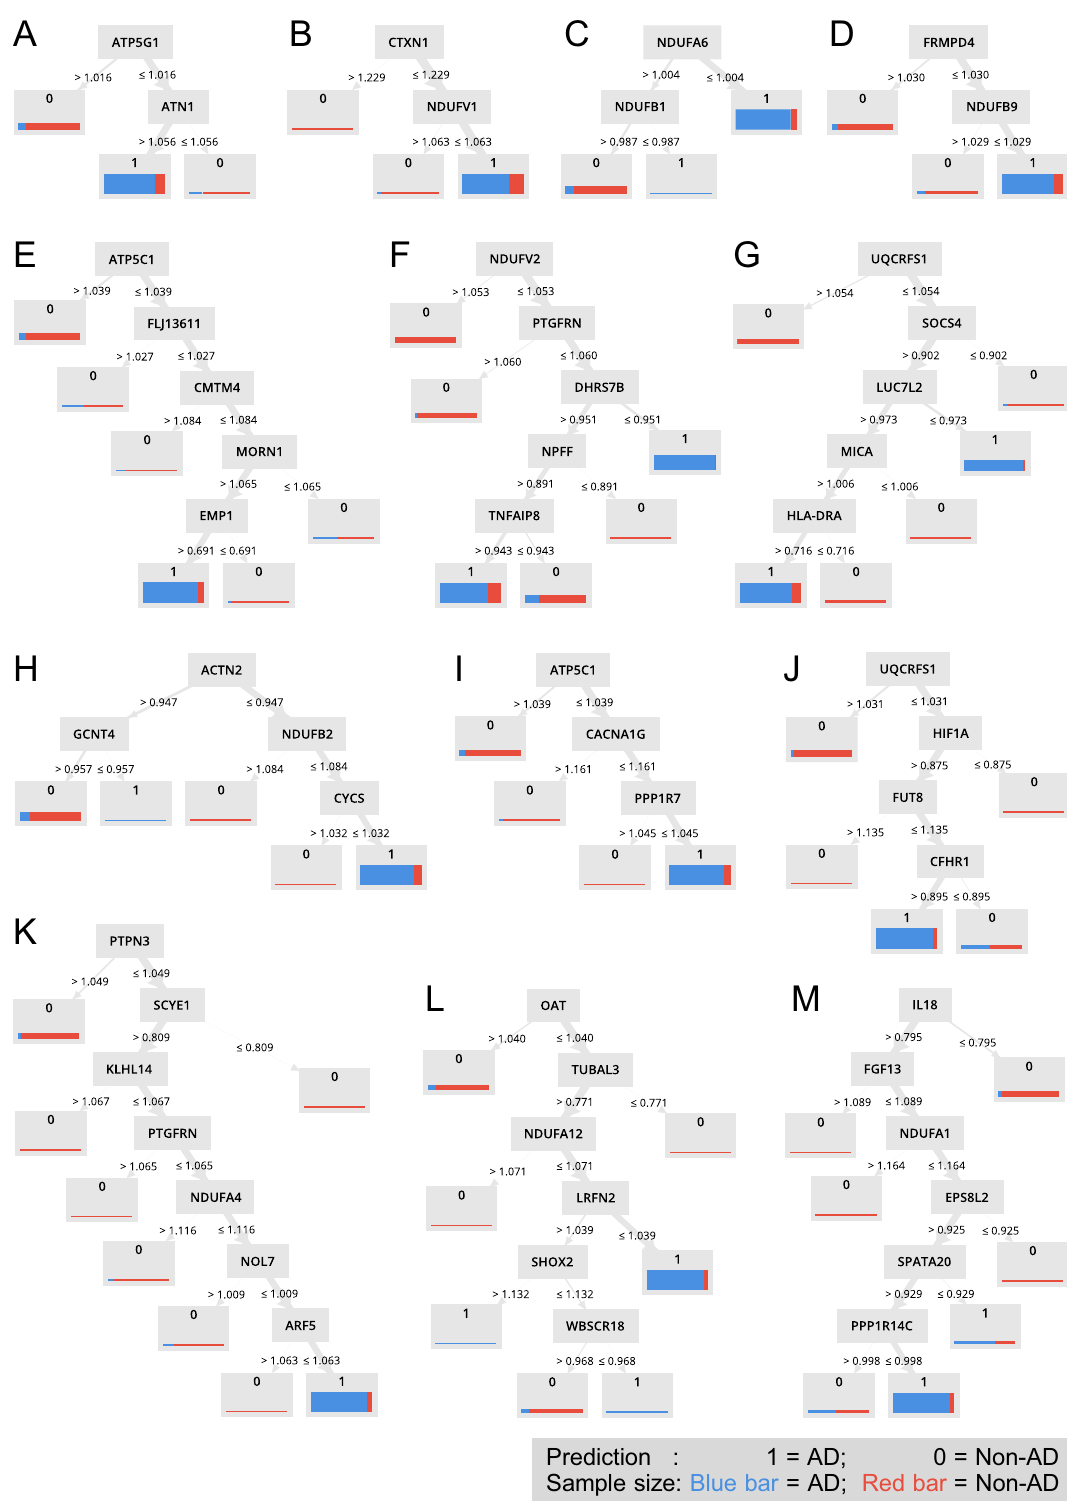
Figure 5. Slightly down-regulated oxidative phosphorylation genes predict AD. ( A ) to ( M ) The decision trees from the random forest model containing NDUFA1, NDUFA4, NDUFA6, NDUFA12, NDUFB1, NDUFB2, NDUFB9, NDUFV1, NDUFV2, UQCRFS1, ATP5F1C, and ATP5MC1. The prediction outcome is denoted by 0 and 1, where 1 = AD, and 0 = Non-AD. The sample size is denoted by the thickness of the bar, while the sample type is denoted by blue or red, where blue bar = AD, and red bar =